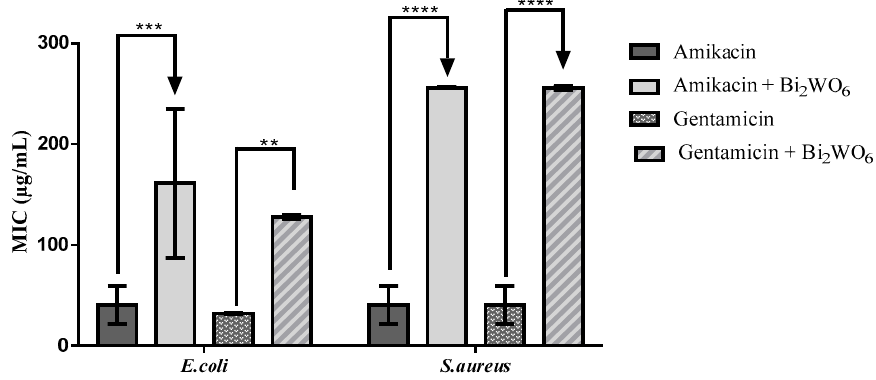
Figure 6. MIC of amikacin and gentamicin alone, or in the presence of Bi 2 WO 6 monolayers, against multi-drug resistant strains of S. aureus and E. coli . **** p < 0.0001, *** p < 0.001, ** p < 0.01. The association of aminoglycosides under visible light irradiation may represent a promising strategy in the treatment of skin infections caused by resistant bacteria. There- fore, in this study the antibiotic-modulating effects of LED light exposure associated or not with Bi 2 WO 6 nanosheets was investigated (Figure 7). No potentiation of the action of aminoglycosides associated with Bi 2 WO 6 nanosheets against Gram-positive and Gram- negative strains was stated, regardless of LED wavelength. Thus, the strong antagonistic effects observed when aminoglycosides were used in combination with Bi 2 WO 6 nanosheets under visible light irradiation against Gram-positive and Gram-negative strains seem to be related to the high photocatalytic potential of bismuth tungstate in de- grading organic compounds [8,9].